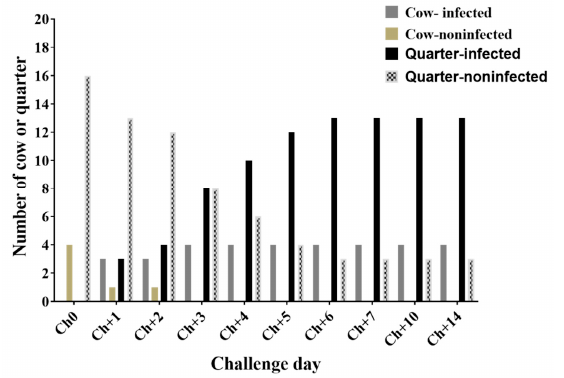
Figure 1. Intramammary infection status of cows or quarters with S. aureus during challenge period. Ch0: immediately before the challenge, days 1 to 7 of challenge (Ch+1–Ch+7), days 10 and 14 of challenge (Ch+10 and Ch+14).